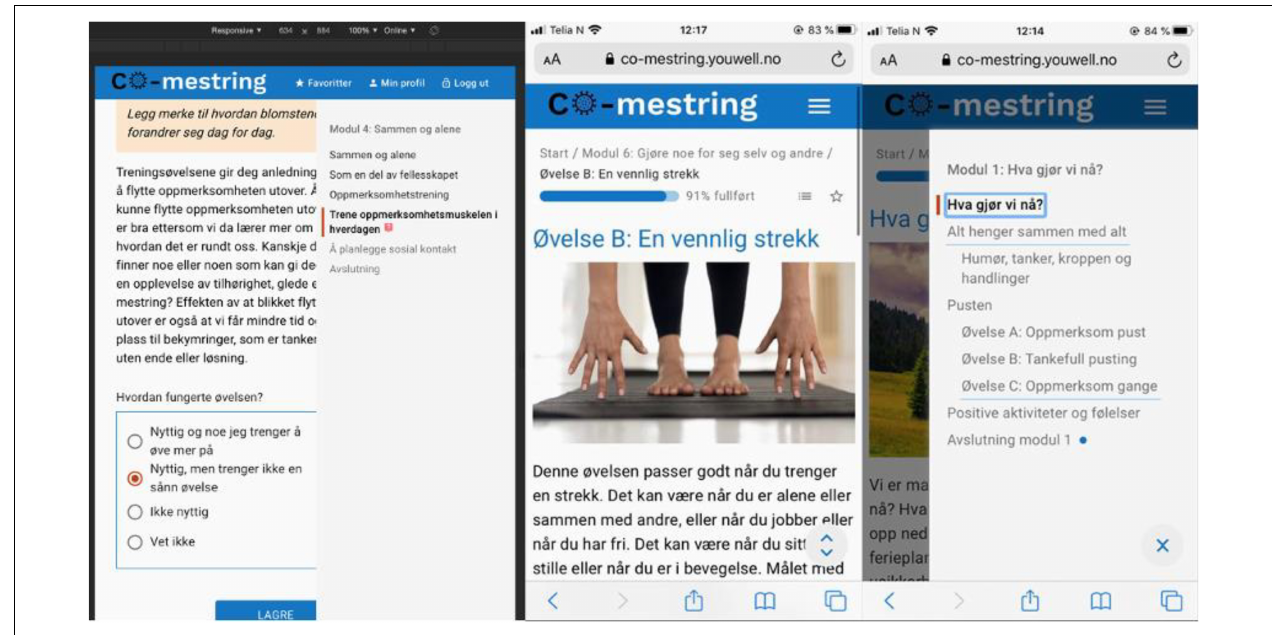
FIGURE 1 | Illustration of the program